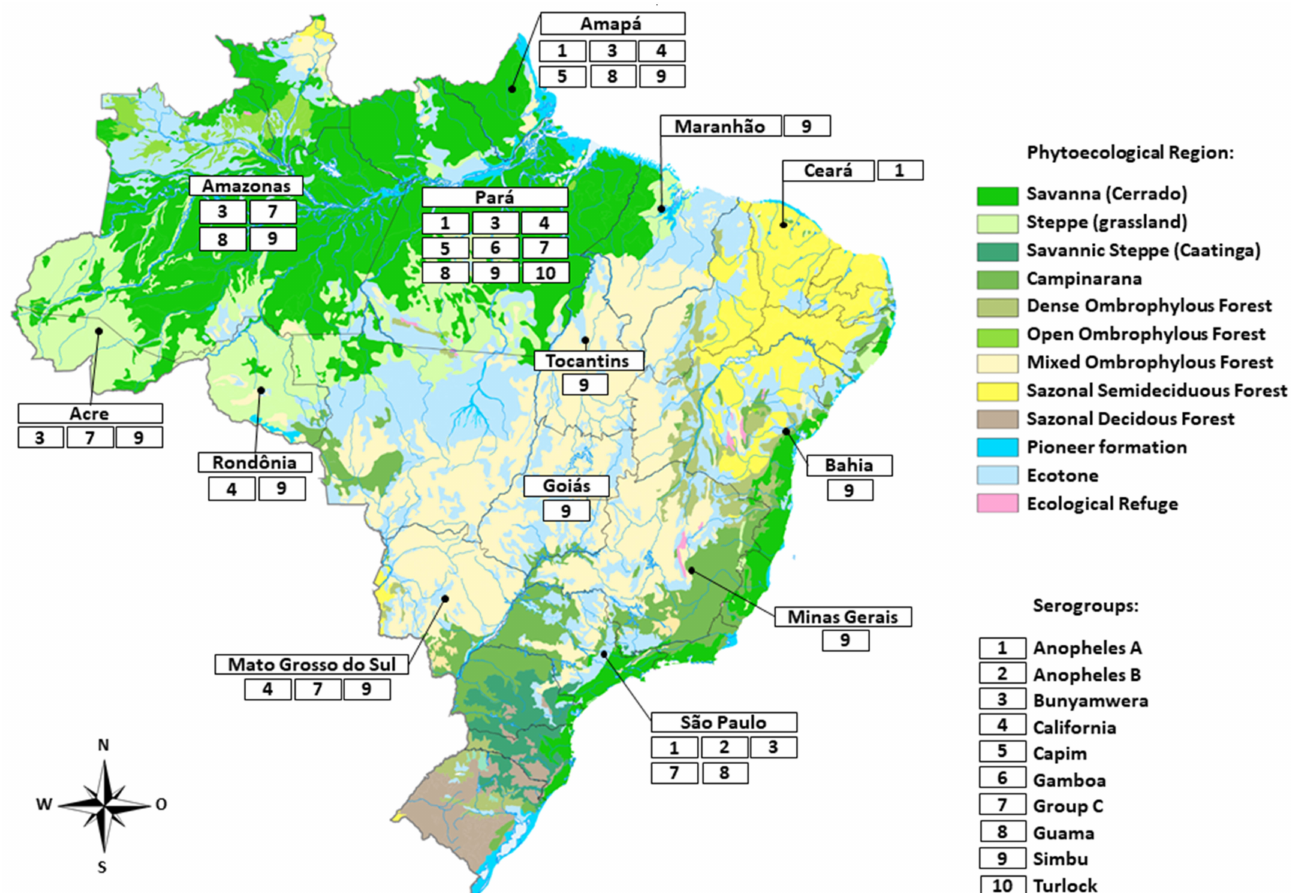
Figure 2. Map of Brazil showing states where orthobuniaviruses of several serogroups have been